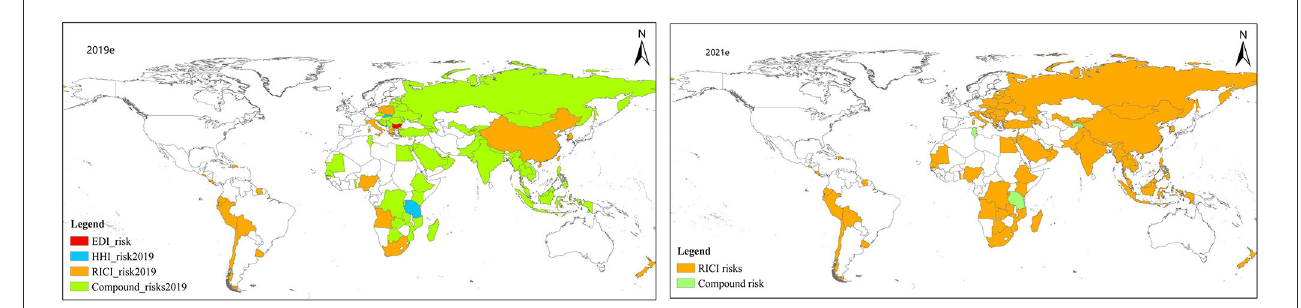
FIGURE7 Spatial pattern of the dominant risk of Agricultural products security in 2019 and